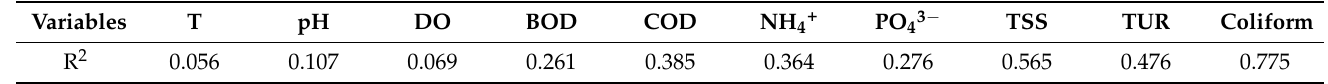
Table 2. Coefficient of determination (R 2 ) between the ten WQ variables and WQI.